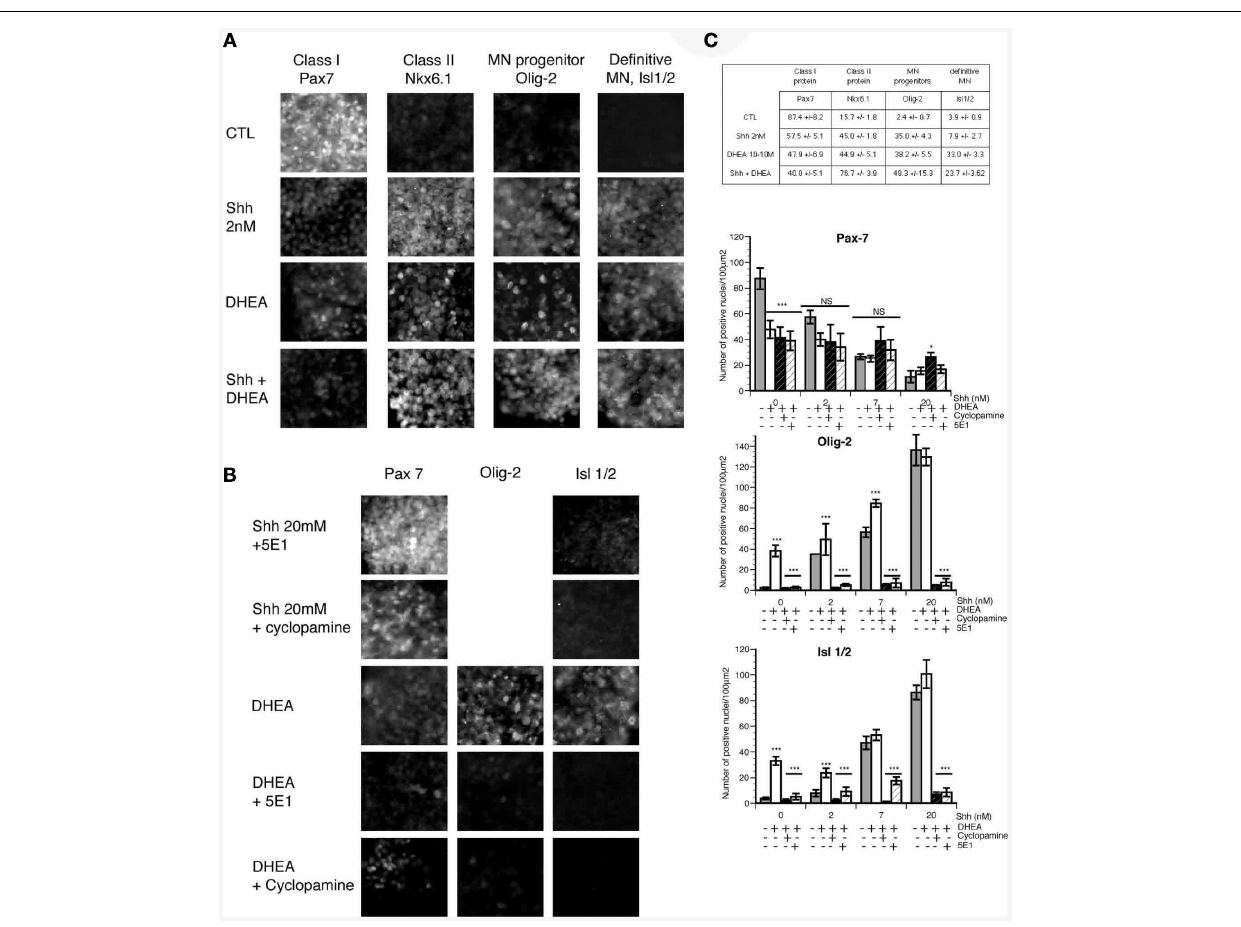
cyclopamine, an antagonist of Shh signaling. (C) Quantification of (A) is shown in the table. Data are the number of immunopositive cells per 100 μ m 2 ± SEM. Quantification of (B) and of all the other conditions tested is shown in the different graphs representing the number of immunopositive cells per 100 μ m 2 ± SEM for Pax7, Olig-2, and Isl-1/2 respectively. A MANOVA analysis was performed to determine the influence of the dose of Shh used and that of the composition of the culture medium. Differences between the different medium compositions at every single dose of Shh were determined by ANOVA and Bonferroni post hoc analysis. * = p < 0.05, ** = p < 0.001, *** = p <